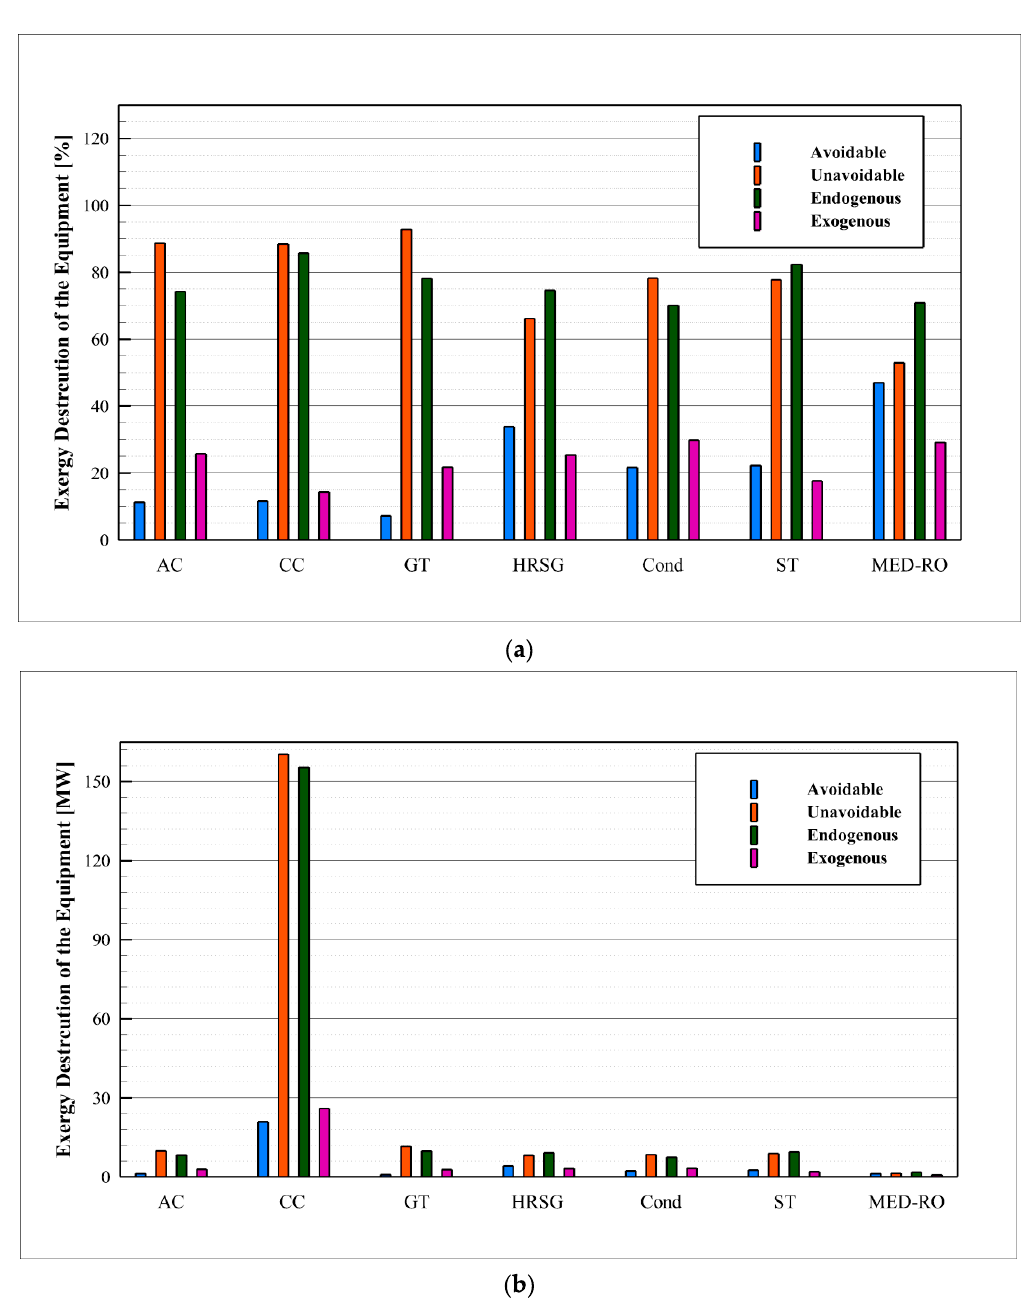
Figure 6. Distributions of avoidable/unavoidable and endogenous/exogenous exergy destruction for different system components in ( a ) relative values, and ( b ) quantitative values. AC, air compressor; CC, combustion chamber; GT, gas turbine; HRSG, heat recovery steam generator; Cond, condenser; ST, steam turbine; MED-RO, multi-effect distillation and reverse osmosis